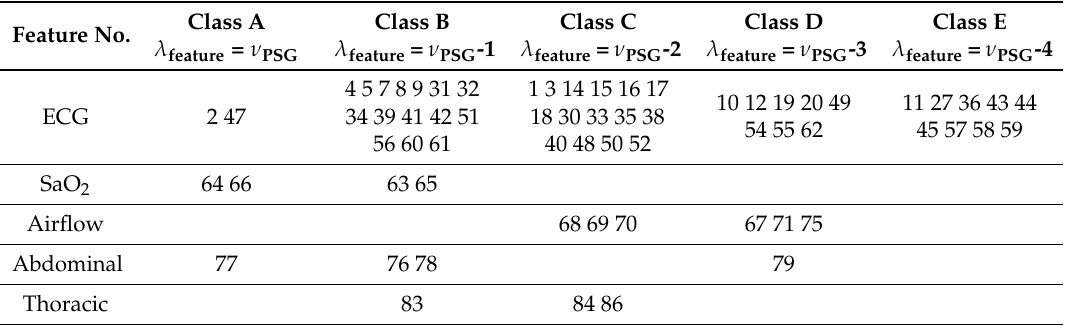
Table 2. Feature classes obtained via the relationship between λ feature and ν PSG . Feature